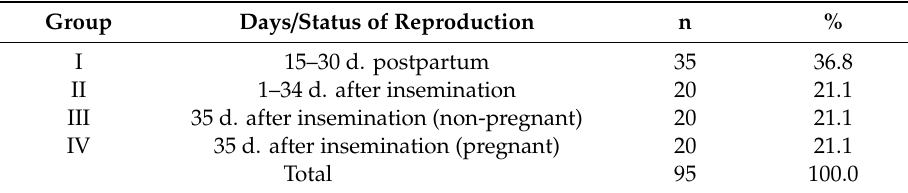
Table 1. Creation of experimental